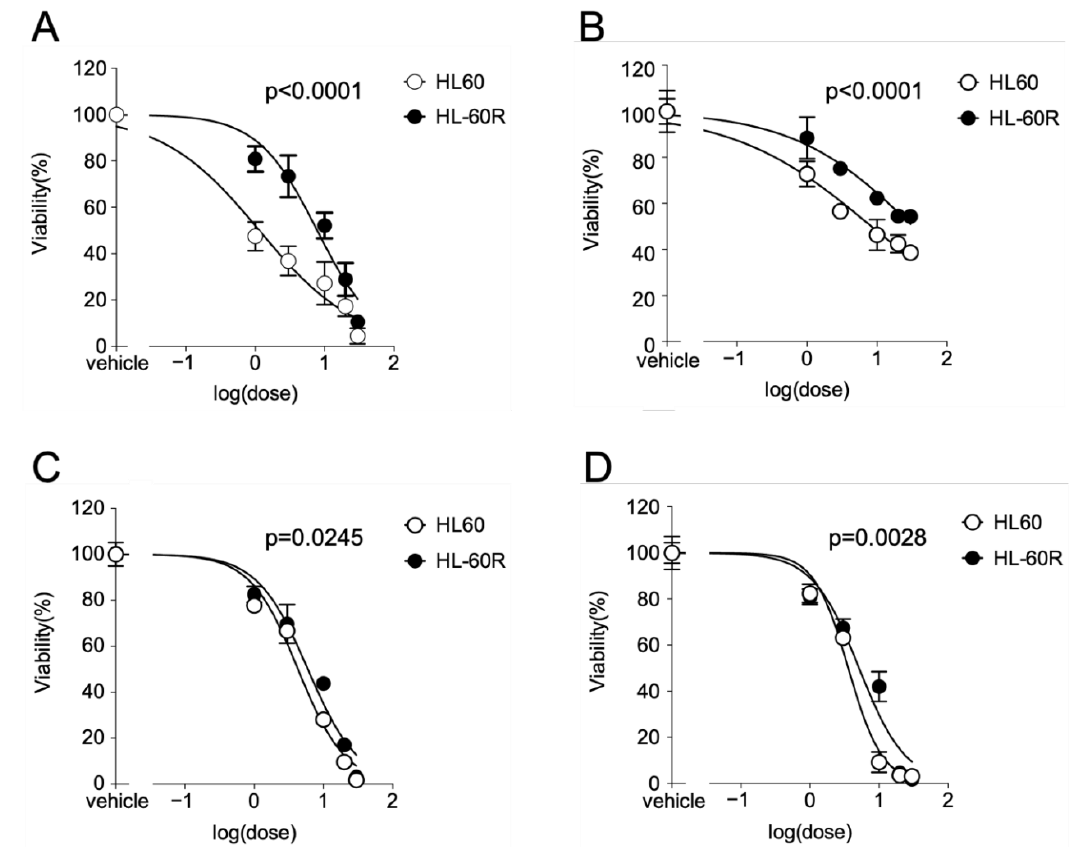
Figure 2. Inhibitory effects of ATRA, MK-4, and MKH derivatives on the viability of HL60 and HL-60R cells. Cells were treated with 1–30 µ M ATRA ( A ), MK-4 ( B ), MKH-DMG ( C ), or MKH-SUC ( D ) for 72 h. Plotted values are mean ± SD (n = 3). p values were analyzed using the extra sum-of-squares F test. Table 1. IC 50 values of ATRA, MK-4, and MKH-ester derivatives in HL60 or HL-60R cells after 72 h. Compound ATRA